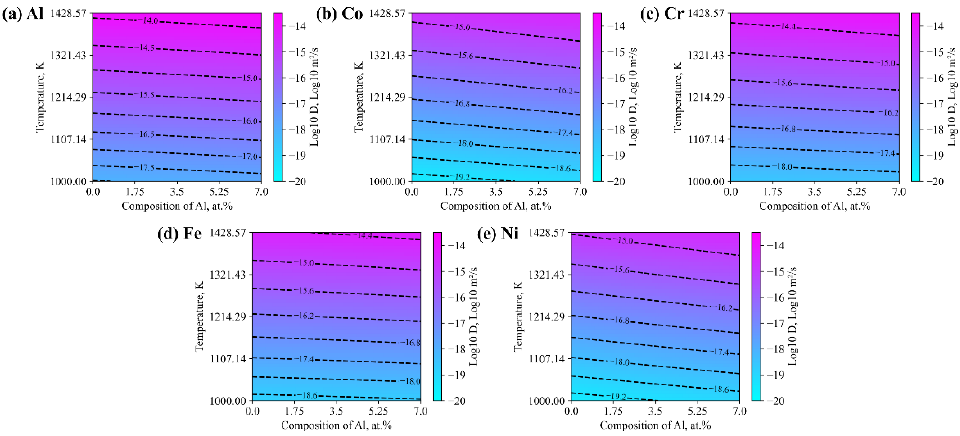
Figure 6. Influence of aluminum content on the tracer diffusion coefficients of the Alx(CoCrFeNi)1-x alloys: ( a ) D ∗ ; ( b ) D ∗ ; ( c ) D ∗ ; ( d ) D ∗ ; ( e ) D ∗ Co Cr Fe Ni Al